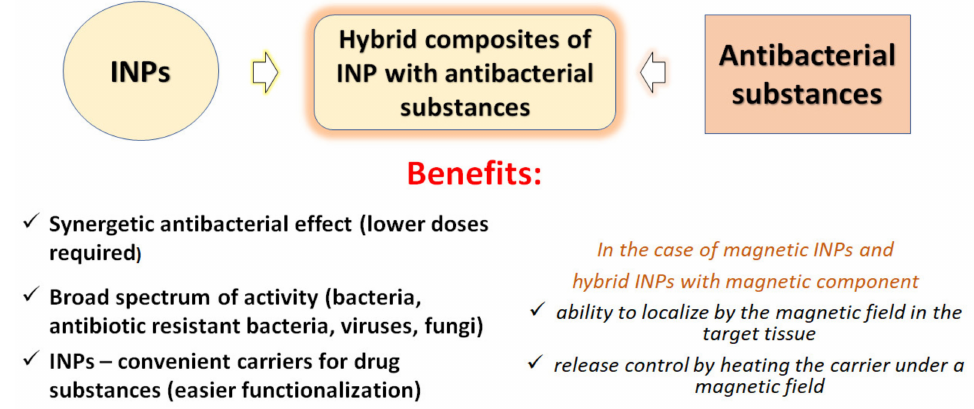
Figure 3. Benefits of INPs as components of new-generation antibacterial